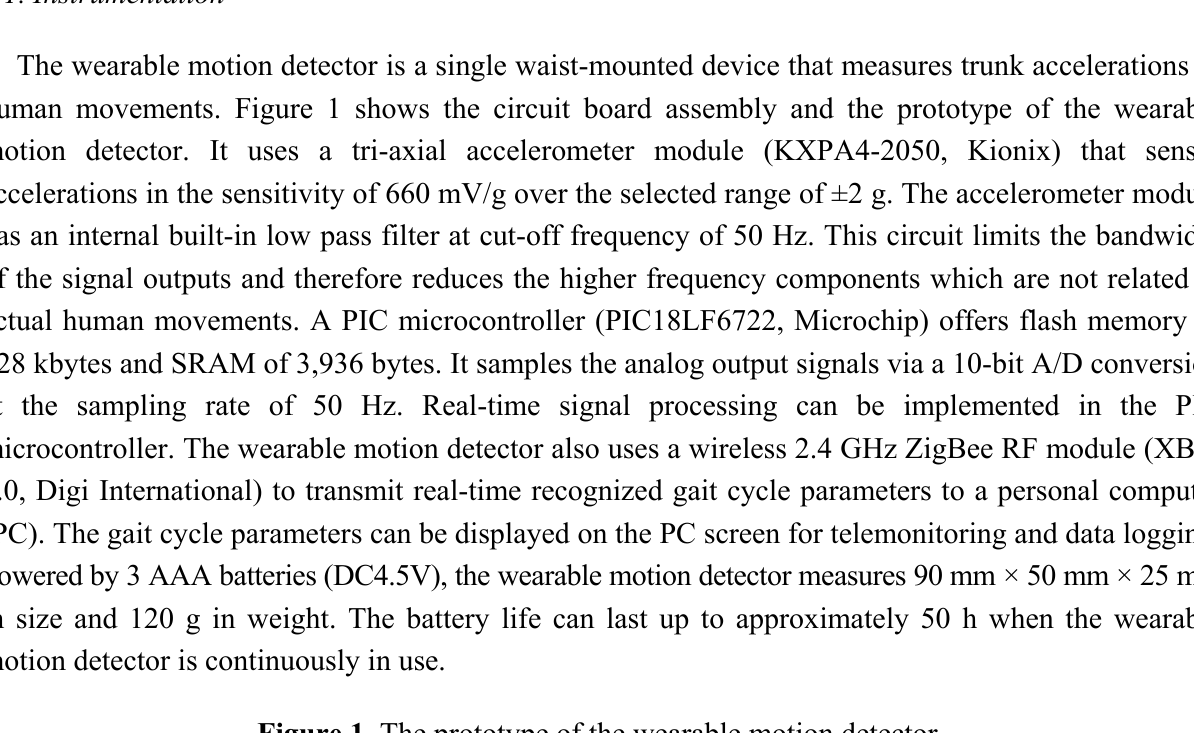
Figure 1. The prototype of the wearable motion